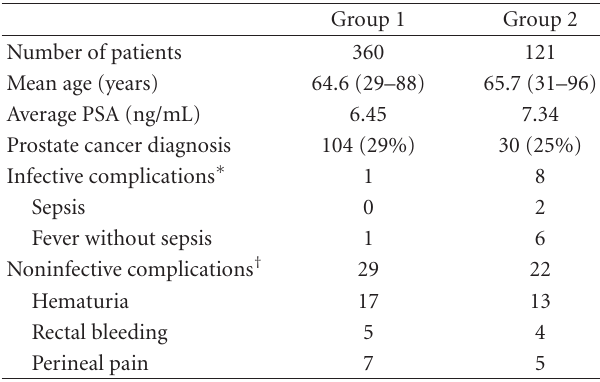
Table 1: Demographic data of patients.